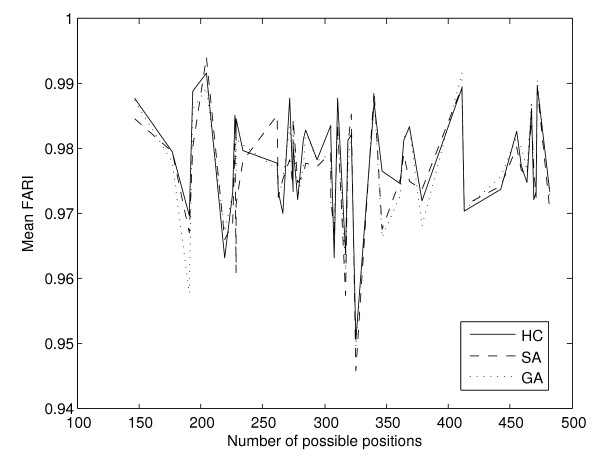
Mean FARI between allocations per experiment, according to number of possible genes to pathways allocations. For the FARI values between allocations produced by subsequent runs of each method there is no correlation whatsoever with the size of the search space, as defined by the number of possible multi-membership genes' allocations.